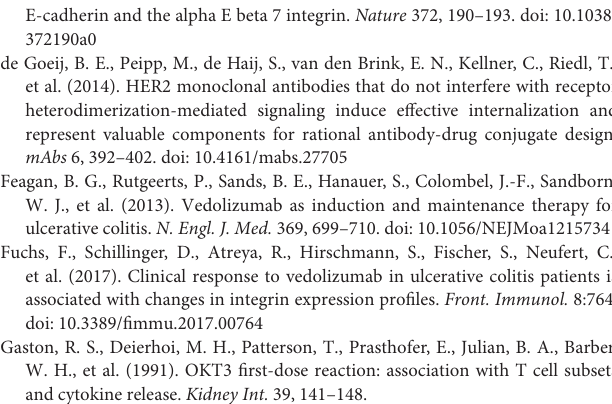
FIGURE S1 | Concentration of cytokines and chemokines in supernatants of human PBMCs incubated with different antibodies with or without stimulation with anti-CD3 after 24 and 48 h. FIGURE S2 | Incubation with vedolizumab hinders binding of Act-1. Representative dot plots showing binding of AF647-labeled Act-1 to PBMCs treated with (left) or without (right)